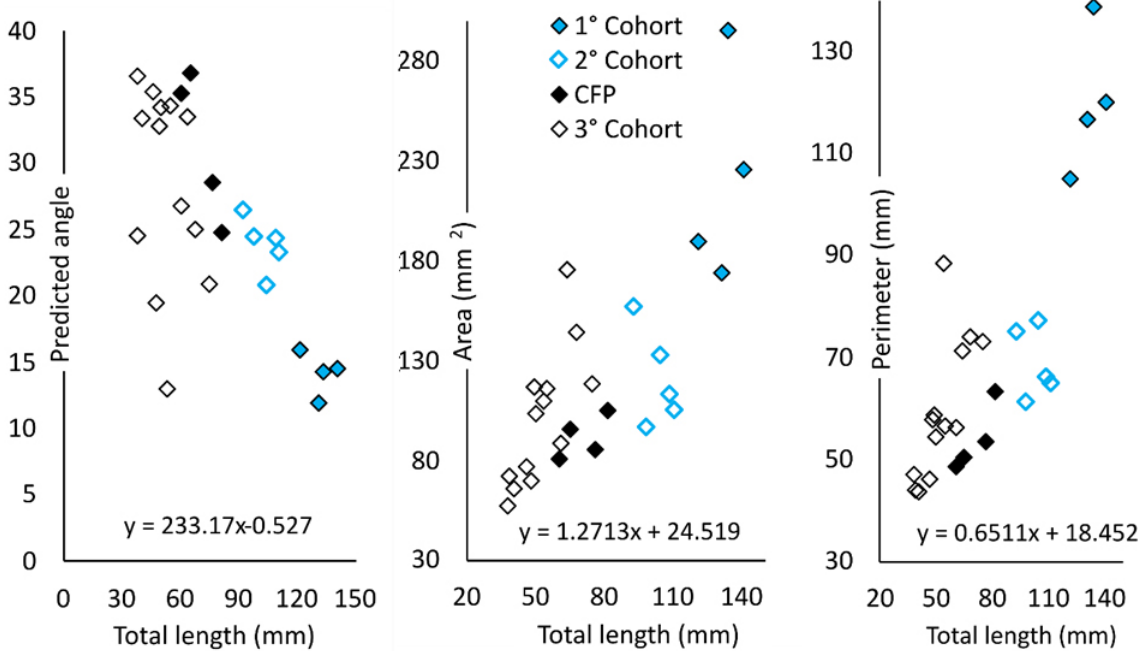
Figure 22. Left: Predicted angle of the edges of the blades. Centre: cross-sectional area of the blades. Right: perimeter of the blades. Area and perimeter are based on Hughes (1998), modified by Sisk & Shea (2011). CFP: included the classic Fishtail projectile points, pieces 11, 13, 16 and 19 from Figure 3 (piece 12 lacks